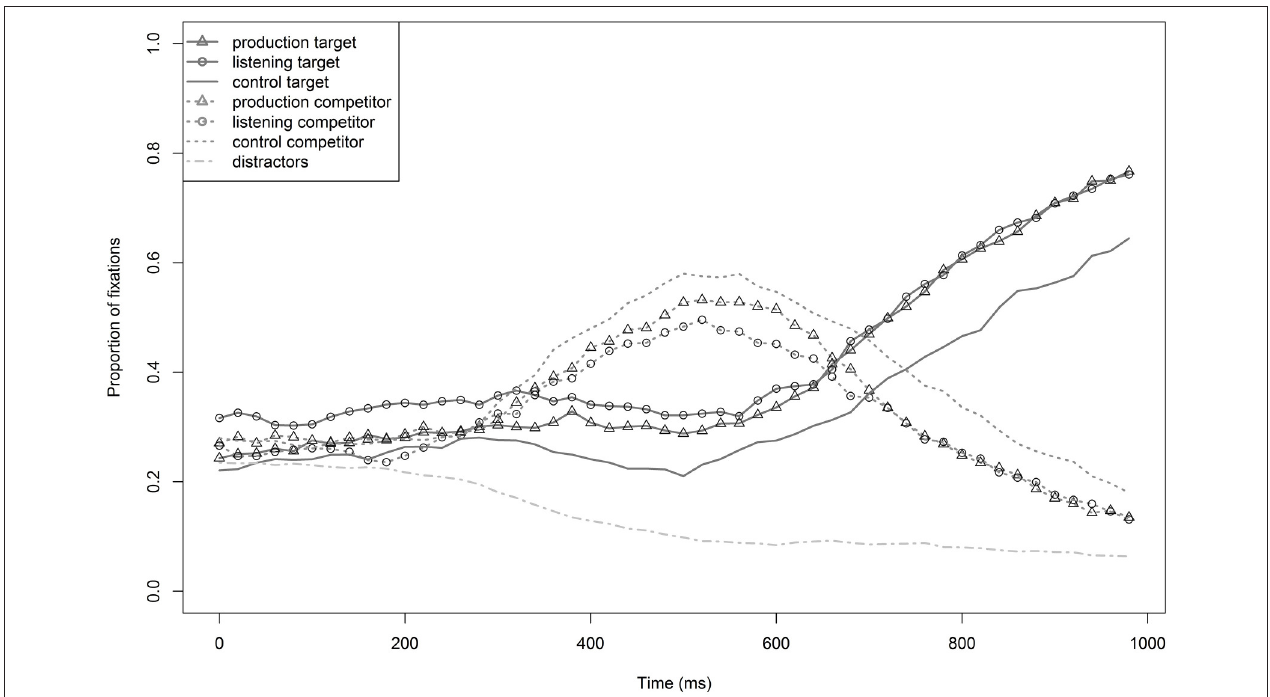
FIGURE 2 | Proportions of target ( BALKEN ) and competitor ( PALME ) fixations of the production, the listening, and the control group in Experiment 1. The bottom line describes the mean number of distractor fixations of all three groups.